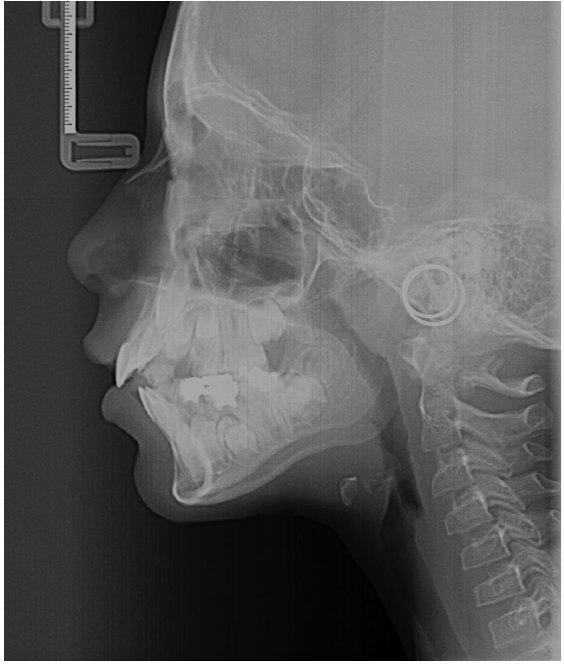
Figure 1. A sample of lateral cephalometric radiographs.